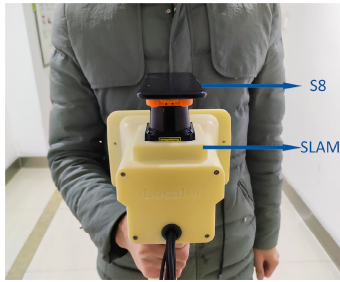
Figure 9 . Two employed devices Figure 9. Two employed